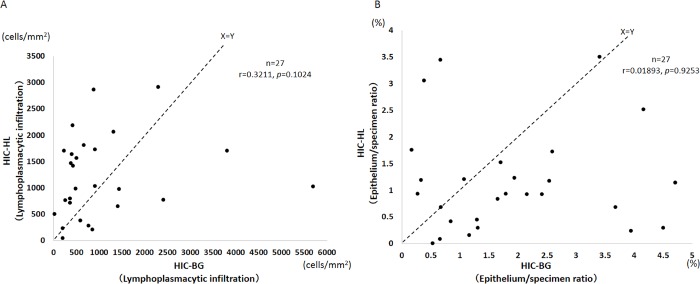
Inflammation and epithelial denudation in HIC cases.(A) Each case of Hunner-type/classic IC (HIC) was plotted for lymphoplasmacytic infiltration in Hunner lesion (HIC-HL) and background mucosa (HIC-BG) (n = 27). There was no significant correlation between the degree of inflammation in HIC-HL and that in HIC-BG. In 18 of 27 cases, lymphoplasmacytic infiltration was denser in HLs than in the BG. (B) Each case of HIC was plotted for the epithelium/specimen ratio of HIC-HL and HIC-BG (n = 27). There was no significant correlation between the degree of epithelial loss in HIC-HL and that in HIC-BG. In 19 of 27 cases, the epithelium/specimen ratio was lower in HLs than in the BG.